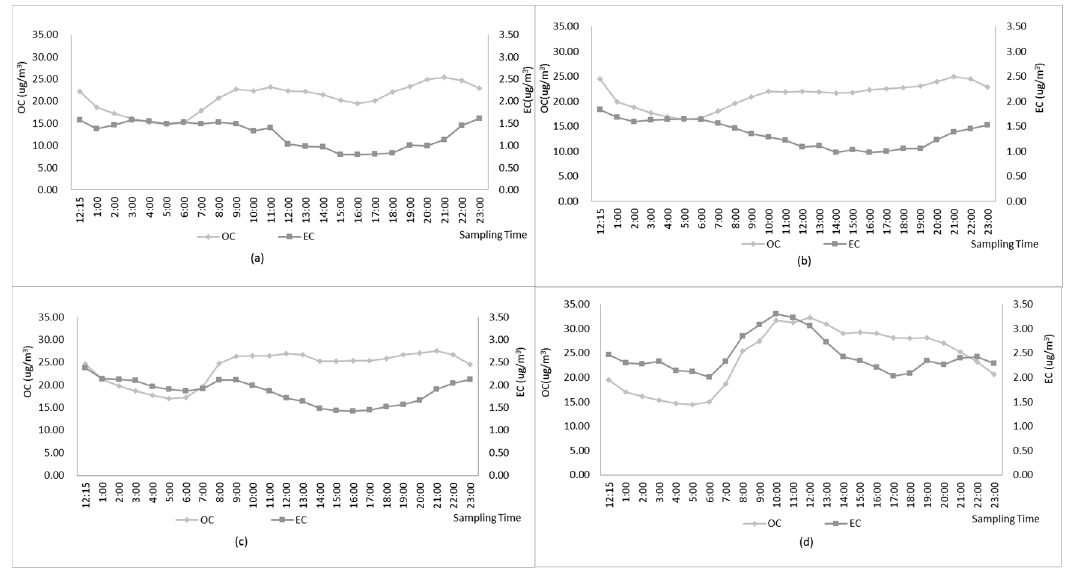
Figure 3. Seasonal variations of OC and EC concentration.